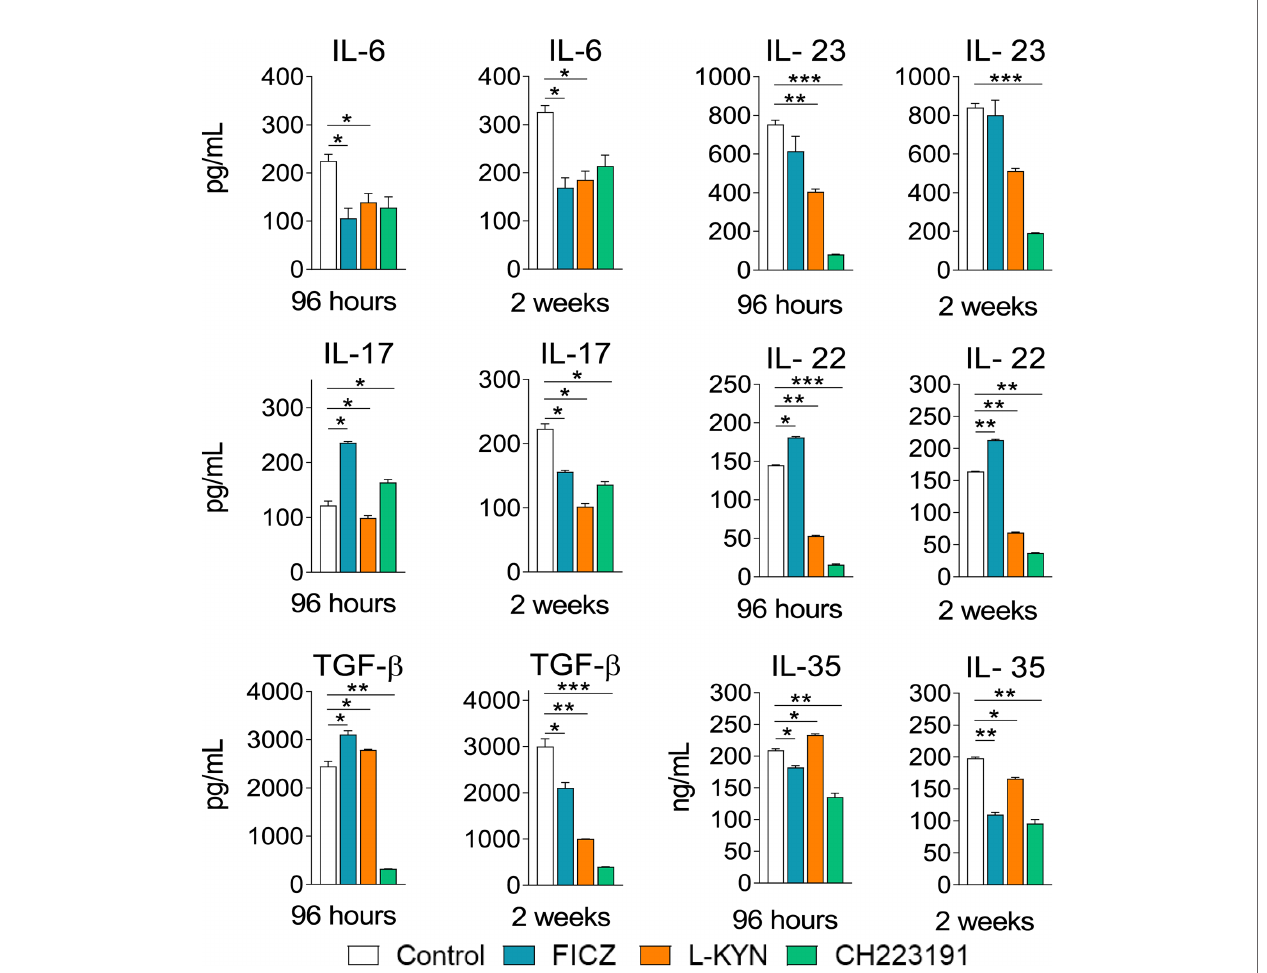
FIGURE 8 | Treatment with AhR ligands alters the levels of pulmonary cytokines involved with Th17 and Treg cells development and activity. C57BL/6 mice (n = 5) were infected with 1 x 10 6 P. brasiliensis yeasts and treated with FICZ, L-Kyn, CH223191, as previously described. Control mice were treated with PBS. The animals were sacri fi ced 96 hours and 2 weeks after infection, their lungs removed, macerated and the supernatants analyzed for the presence of cytokines by ELISA. The experiment was repeated twice, and data are expressed as M ± SD. P values < 0.05 were considered signi fi cant (* p < 0.05; ** p < 0.005 and *** p <